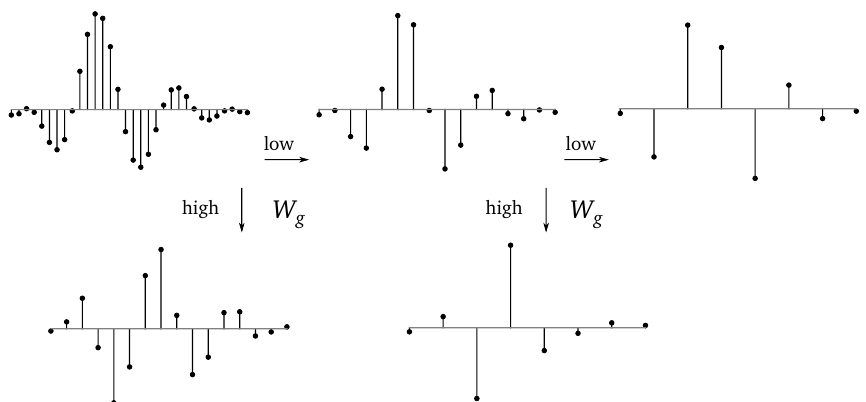
resolves a signal into scales. Illus- g